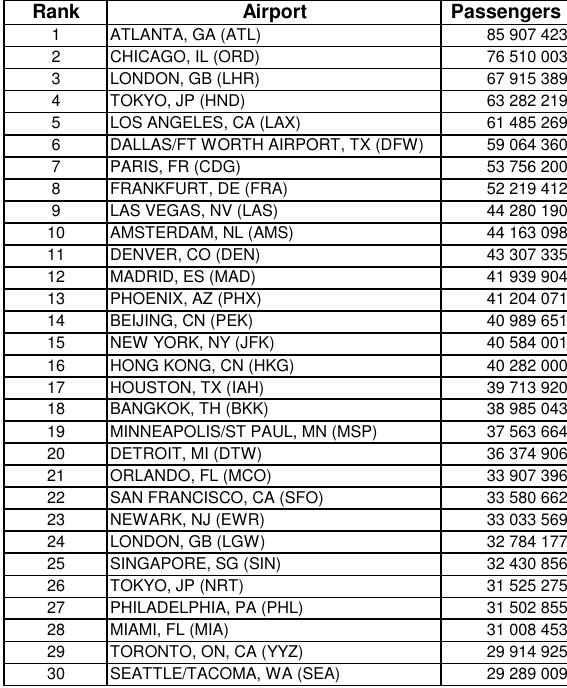
Table 1. The world’s largest airports in